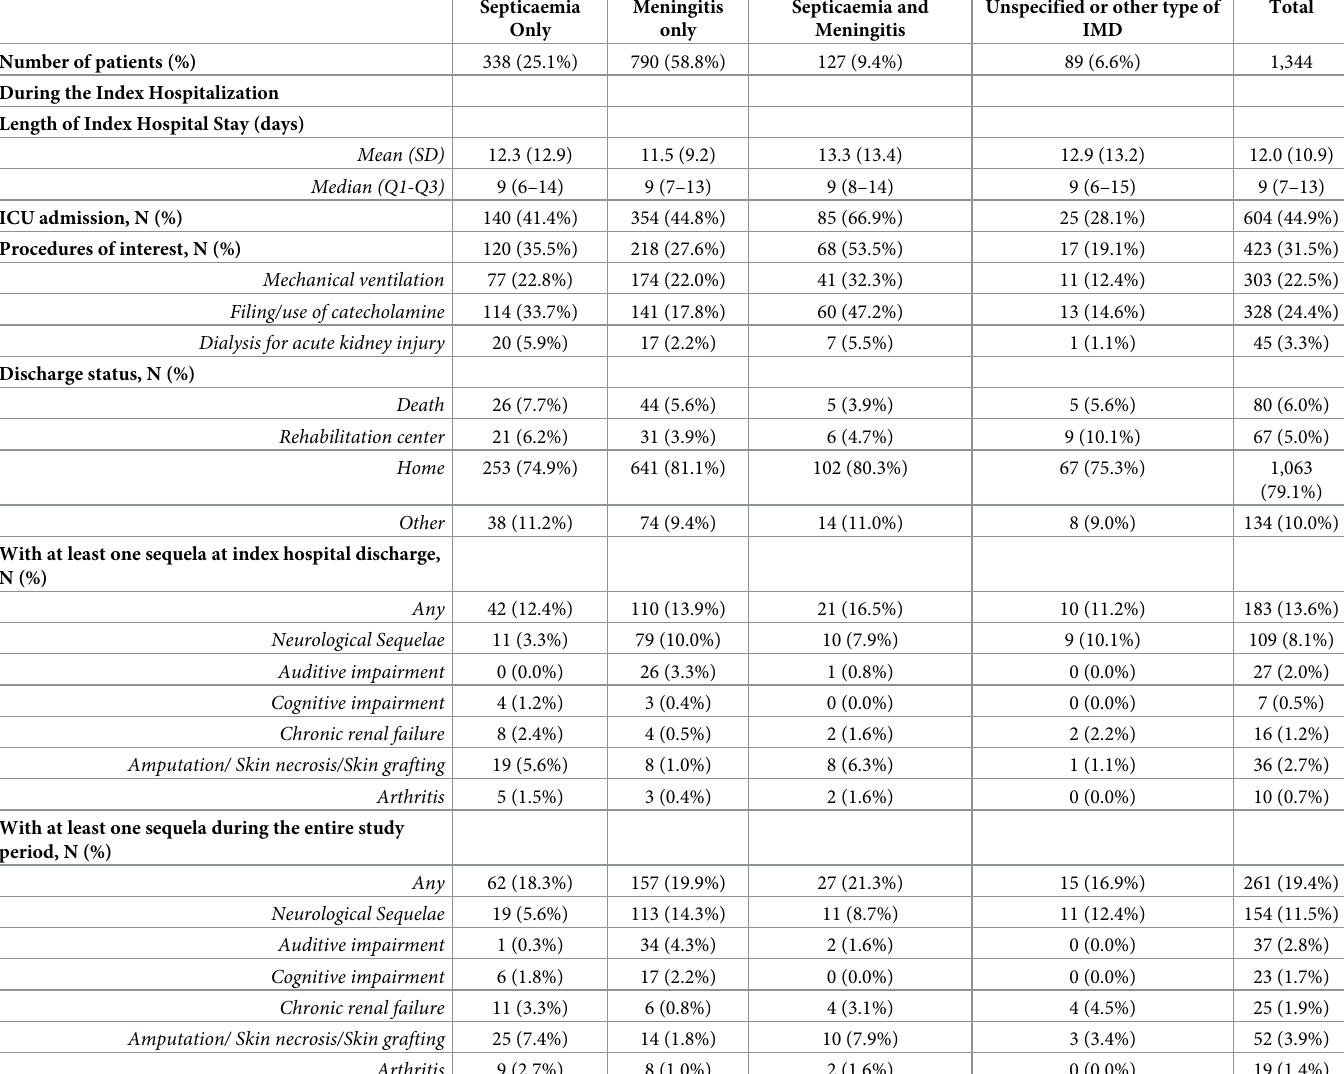
Table 2. Clinical characteristics during the index hospitalization and the entire study